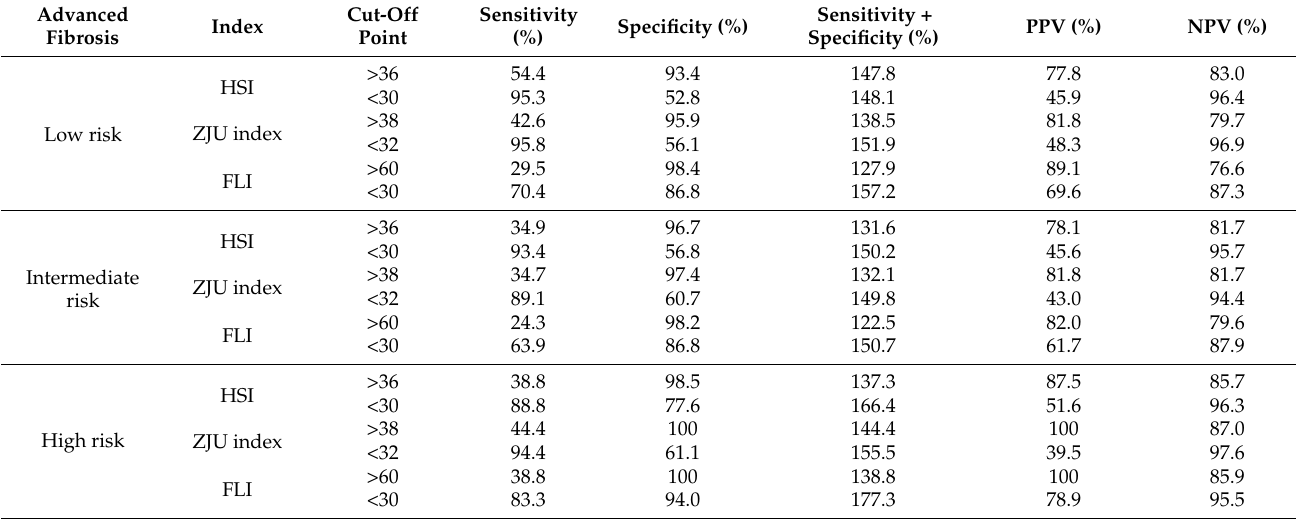
Figure 3. ROC curve of the HSI, ZJU index, and FLI for detecting NAFLD. ROC curve of the HSI (red), ZJU index (green) and FLI (blue) for the diagnosis of NAFLD stratified by the risk of advanced liver fibrosis (stage 3 or severe) evaluated using the FIB-4 index. ( a ) Low risk (FIB-4 index < 1.3); ( b ) intermediate risk (FIB-4 index 1.3–2.67); ( c ) high risk (FIB-4 index > 2.67). The ZJU index and FLI showed a greater AUROC than the HSI in low risk and the ZJU index showed a greater AUROC than the HSI in intermediate risk. * p < 0.05 in comparison between the ZJU index and HSI. † p < 0.05 in the comparison between FLI and HSI by the DeLong test. AUROC, area under the receiver operating characteristic; FIB-4, fibrosis 4; FLI, fatty liver index; HSI, hepatic steatosis index; NAFLD, nonalcoholic fatty liver disease; ROC, receiver operating characteristic; ZJU, Zhejiang University. Table 3. Diagnostic accuracy of the HSI, ZJU index, and FLI by the FIB-4